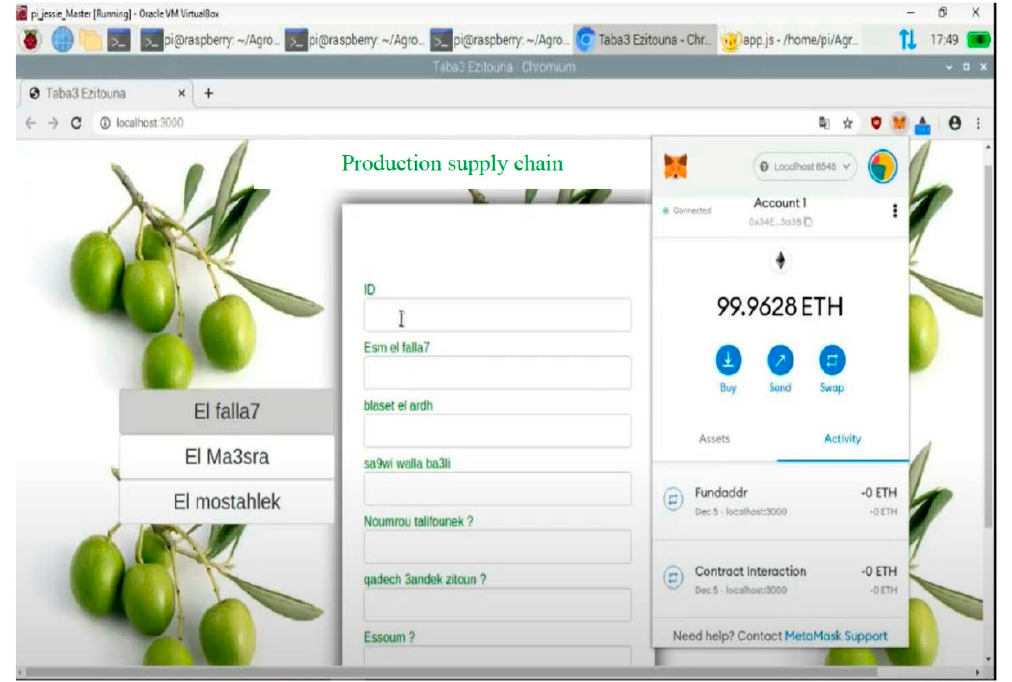
Figure 12. Monitoring and securing production: agriculture interface.